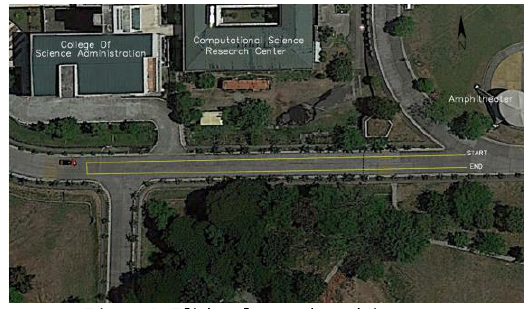
Figure 2. Flight Plan on the subject